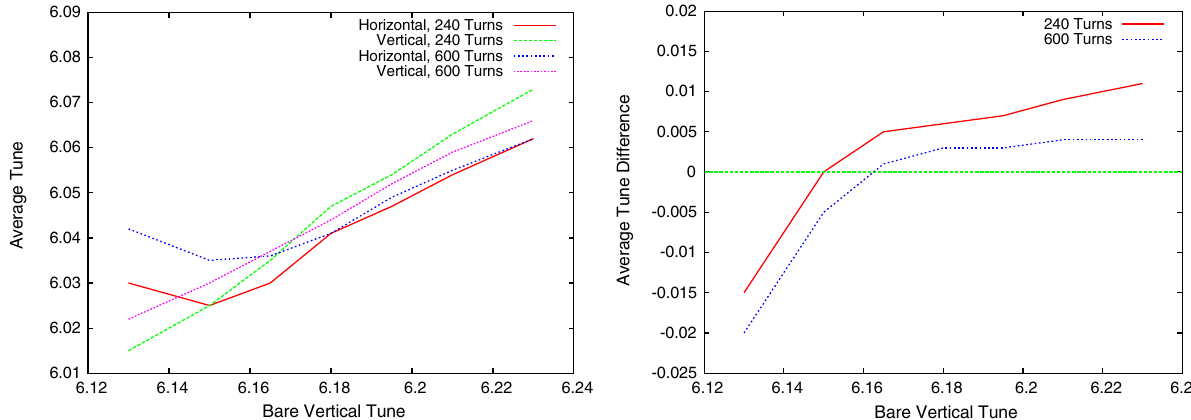
FIG. 9. (Left) Average incoherent horizontal h Q x i and vertical h Q y i tunes versus bare tune Q y at 240 turns (red and green curves) and at 600 turns (blue and pink curves). (Right) Tune difference h Q y i - h Q x i at 240 turns (red curve) and at 600 turns (blue curve). The green line marks h Q y i - h Q x i ¼ 0 , or equal